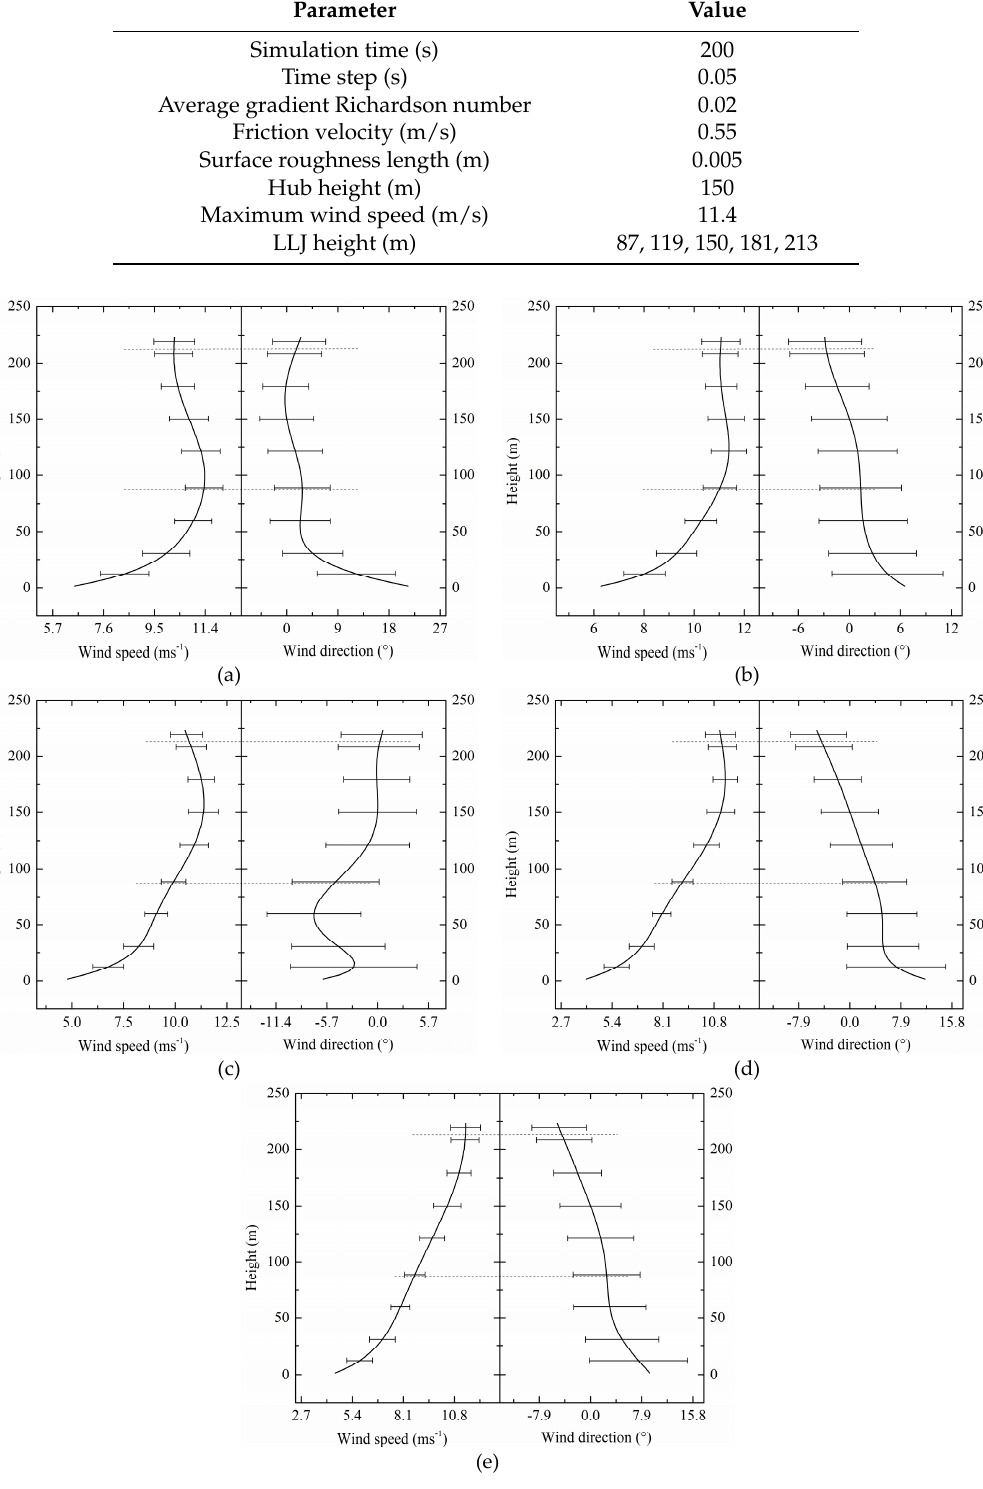
Figure 2. The variations in the simulated time-averaged (200 s) wind speed with height above the Figure 1. The variations in the simulated time-averaged (200 s) horizontal wind speed (left) and wind ground in shear inflow conditions with wind shear exponent α of 0.1, 0.2, and 0.3. The error bars direction (right) with low-level jet (LLJ) height above the ground of ( a ) 87 m, ( b ) 119 m, ( c ) 150 m, represent standard deviation of the mean. The horizontal dotted lines above and below represent the ( d ) 181 m, and ( e ) 213 m. The error bars represent standard deviation of the mean. The horizontal dotted height of the top-tip and bottom-tip of the rotor, respectively. lines above and below represent the height of the top-tip and bottom-tip of the rotor,